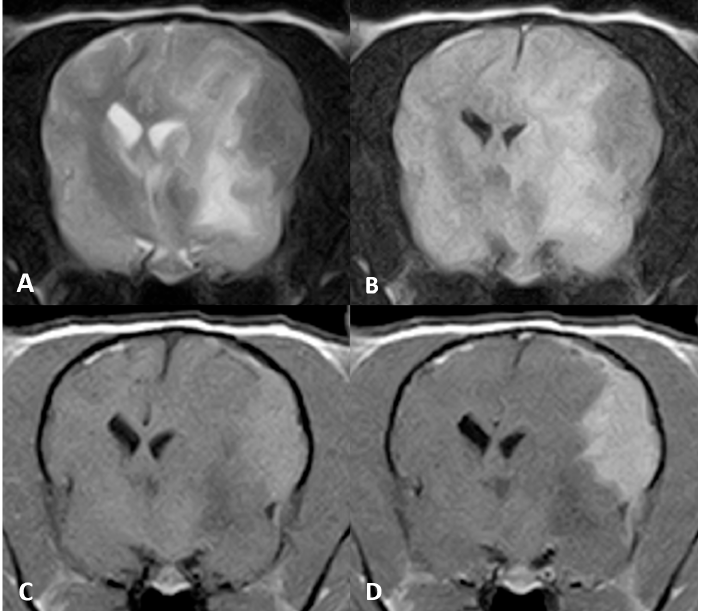
Figure 3. MR imaging of the brain of Case 3, transverse images at the level of the thalamus. An ovoid, plaquelike extra-axial mass is seen in the left parietal cortex. The mass was hypointense on ( A ) T2w and ( B ) FLAIR images. ( C ) Evident T1w hyperintense signal and ( D ) marked enhancement after contrast administration.